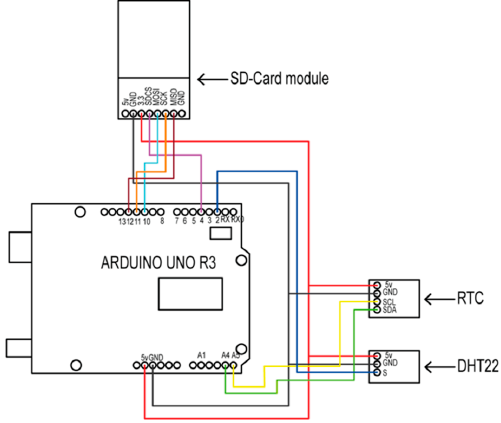
Figure 4. Wiring diagram of a sensor network node with sensors.